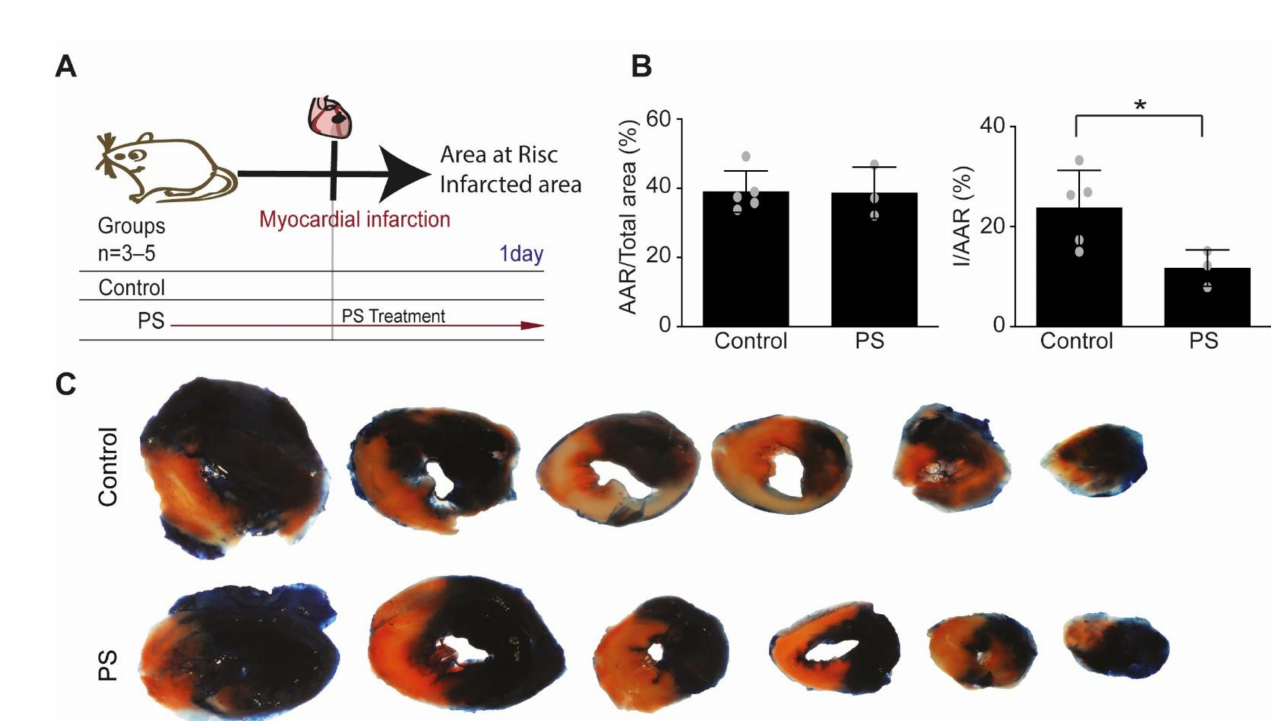
Figure 1. Phosphatidylserine oral supplementation before ischemia-reperfusion confers cardio-protection against acute myocardial ischemia-reperfusion injury. ( A ) Mice were randomly assigned to 2 treatment groups: (1) Control ( n = 5): saline vehicle control by daily oral gavage one week prior to ischemia-reperfusion injury and until end of experiment; (2) PS group ( n = 3): phosphatidylserine was given by daily oral gavage for one week prior to ischemia-reperfusion injury and until the end of experiment; Samples were collected and analyzed one day after ischemia-reperfusion to avoid inflammatory and remodeling interferences. ( B ) There was no difference in the size of the area at risk (AAR) between the two treatment groups. PS treatment reduced MI size (I) as a percentage of the AAR. ( n = 3–5, unpaired Student’s- t test, * p < 0.05, Values ± SD). ( C ) Representative heart sections from both groups are shown (white represents infarcted myocardium, red represents viable myocardium from area of risk, blue represents non-ischemic